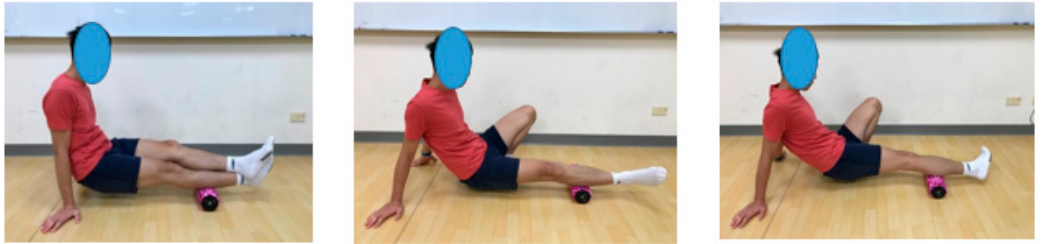
Figure 2. The procedure of roller treatment.